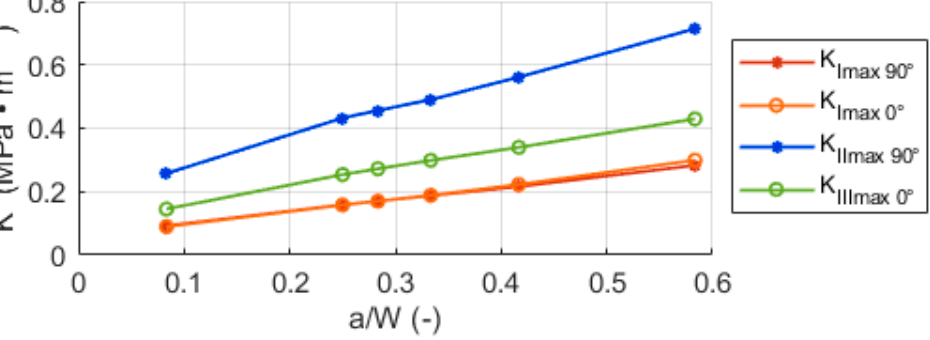
Figure 9. Maximum stress intensity factors in the rolling cycle for different crack tip positions γ depending on the normalized crack length. The indices 0° and 90° indicate the position γ at the crack front.